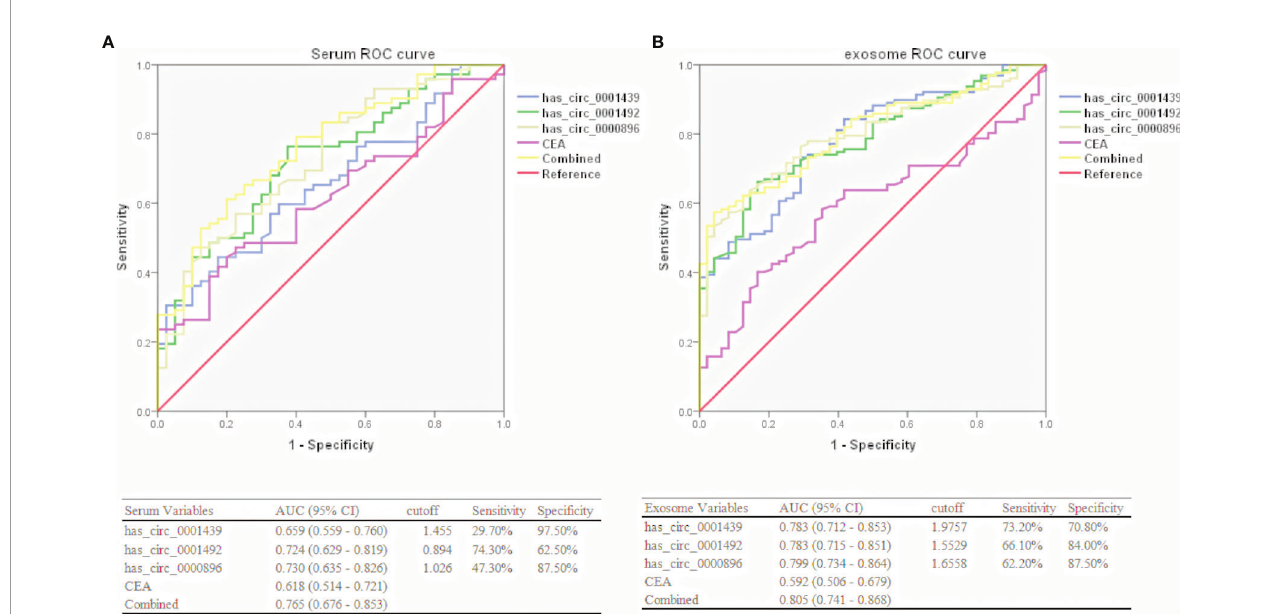
FIGURE 3 | Diagnostic performances of serum (A) and serum exosomal (B) circRNAs in LUAD